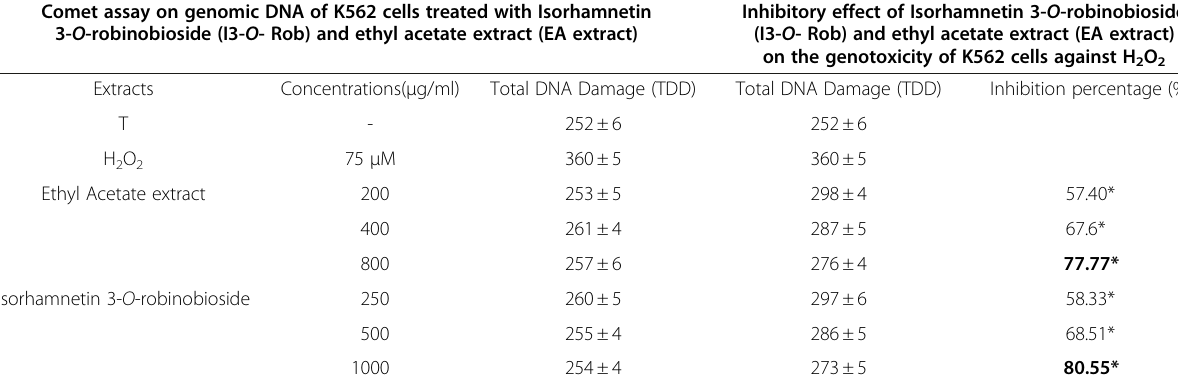
Table 2 Treatment of K562 cell DNA with Isorhamnetin 3- O -robinobioside (I3- O - Rob) and ethyl acetate extract (EA extract) in the presence and abscence of H 2 O 2 in comet